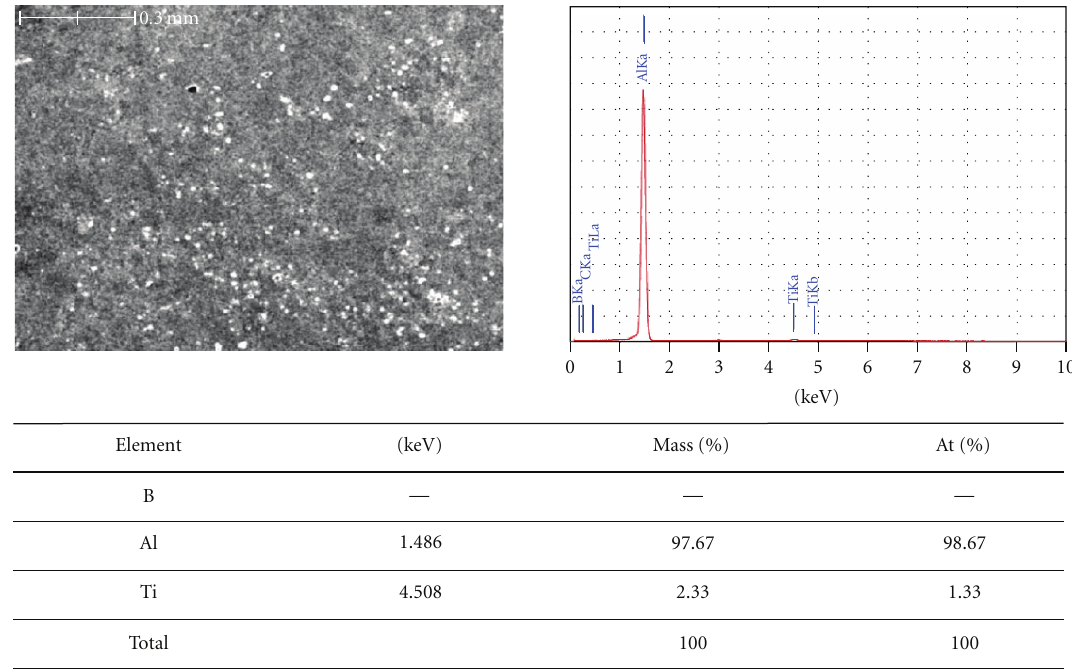
Figure 4: EDX spectrum and elemental mapping of Al-5%TiB 2 composite.